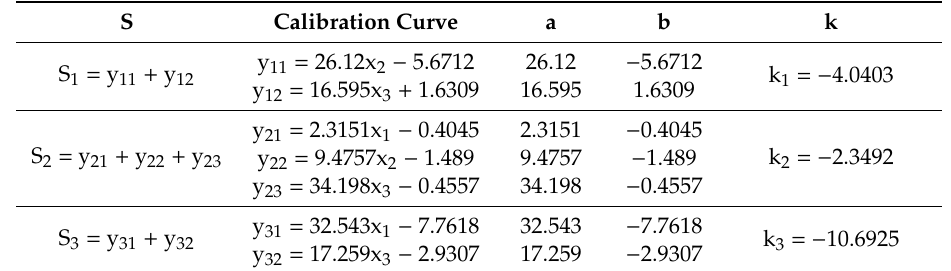
Table 2. Quantitative analysis model parameters for astaxanthin determination from P. rhodozyma , H. pluvialis ,and chemical